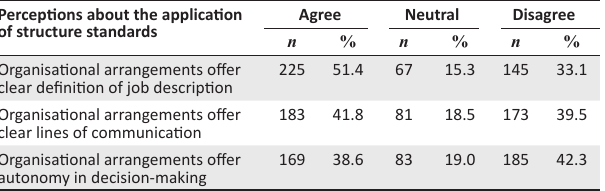
TABLE 3: Nurses’ perceptions about the application of structure standards of the National Core Standards